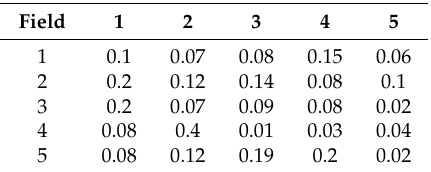
Table 8. Probability of bomb occurring between fields and collecting centers.